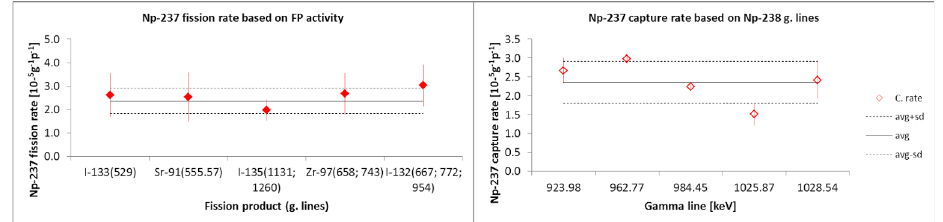
Figure 3. Np-237 fission and capture rate results (experiment 0.66 GeV / p / TS2)